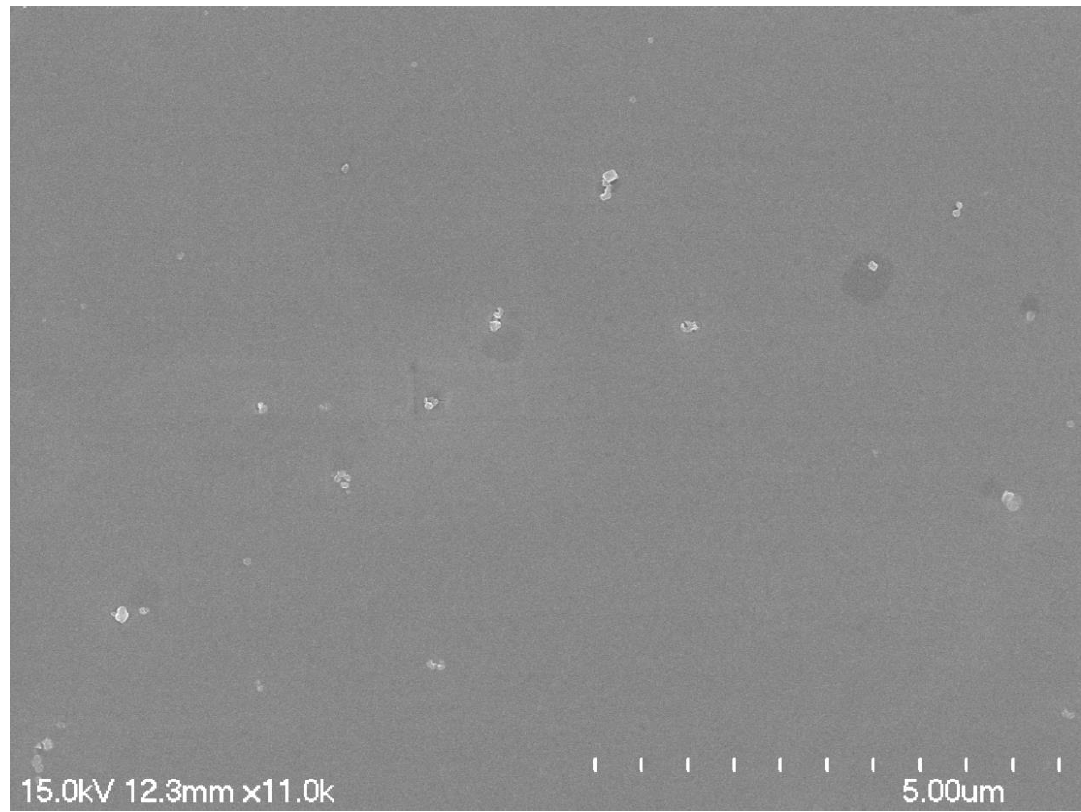
Figure 8. The representative SEM image of the product obtained by using natural evaporation for 60 min.